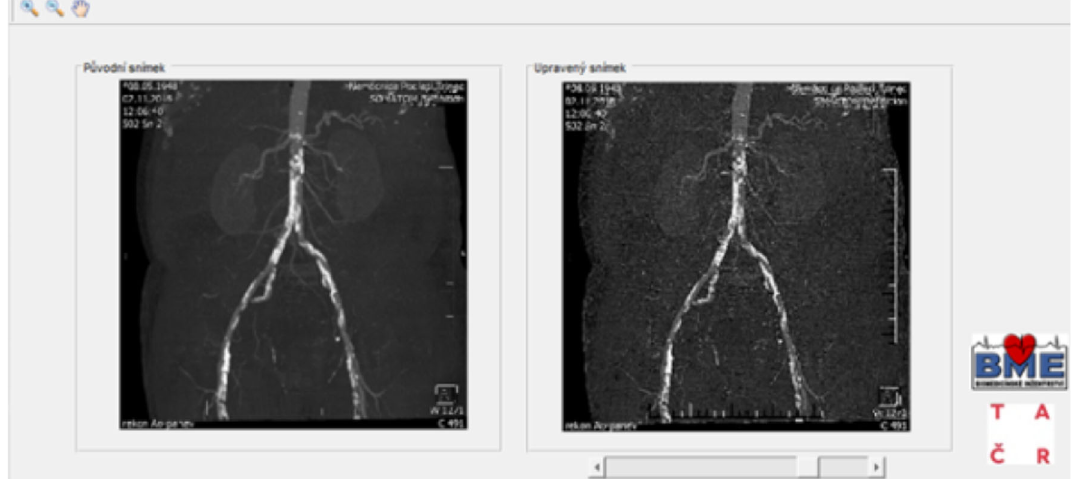
Fig. 8 Native CT image (left) and edge boosting